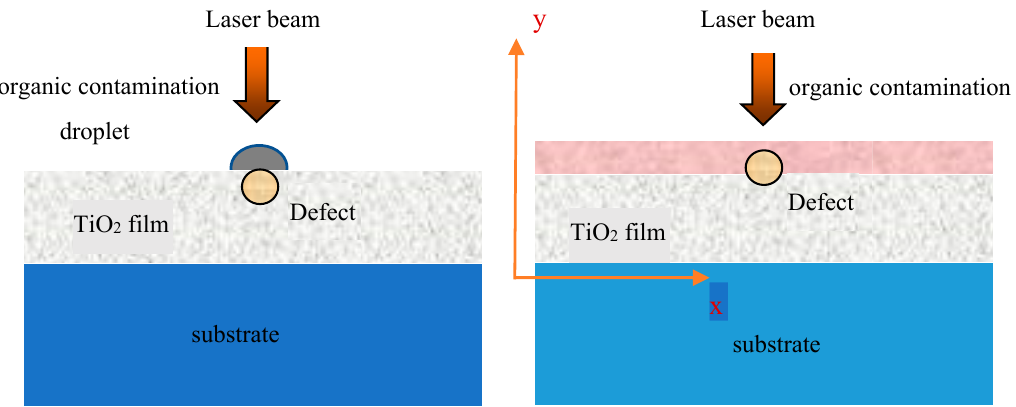
Laser beam Laser beam